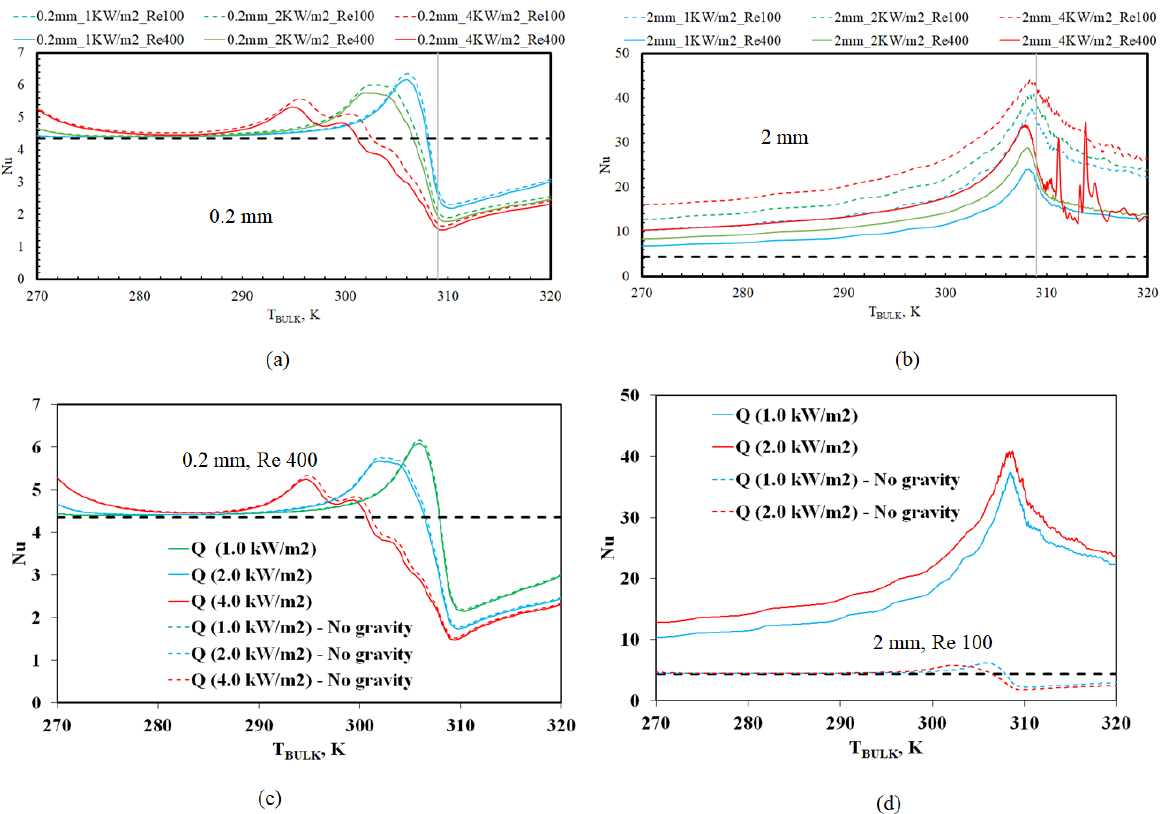
Figure 4. Nu versus bulk temperature (T BULK ) in: ( a ) 0.2 mm diameter tube at different inlet Re and heat fluxes; ( b ) 2 mm diameter tube at different inlet Re and heat fluxes; ( c ) 0.2 mm diameter tube, with and without gravity effects; ( d ) 2 mm diameter tube, with and without gravity effects.